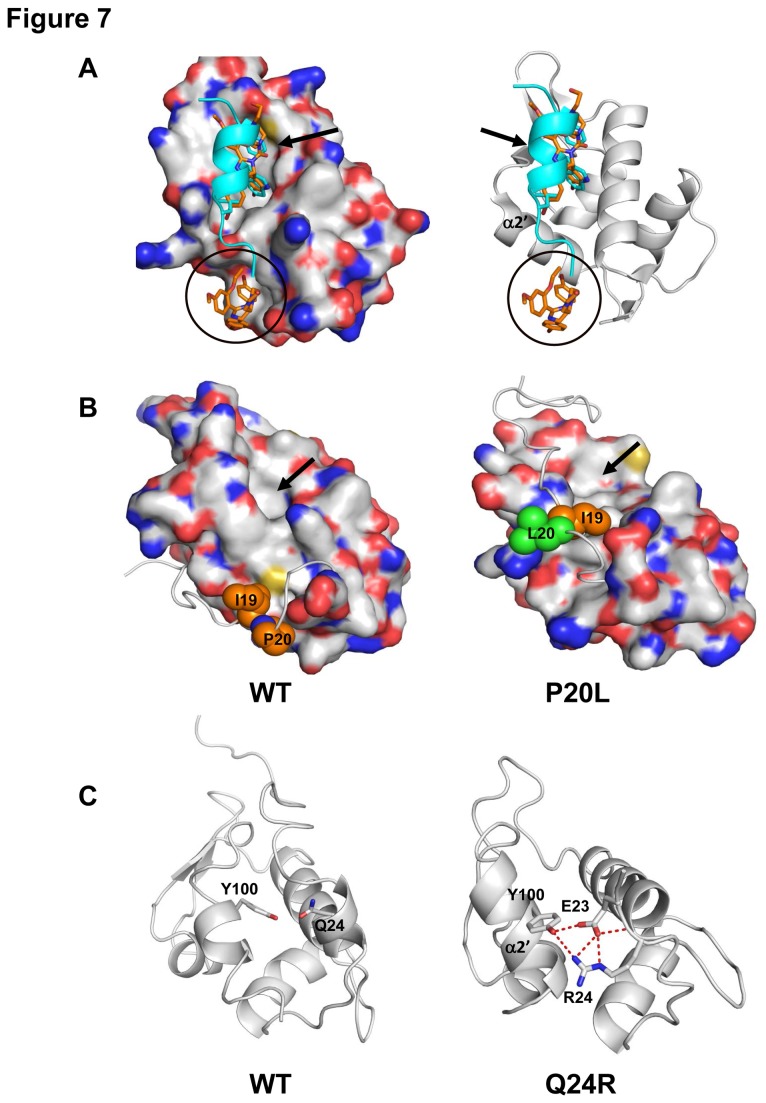
Molecular simulations show negative impact of the P20L and Q24R mutations on the docking of Nutlin to the HDM2 N-terminal domain.A, Space-filling (left) and ribbon (right) depictions of Nutlin (orange) binding the main (arrowed) and secondary (circled) binding sites of HDM2. The p53-peptide (cyan) binding to the main site is overlaid. B, Space-filling model of the HDM2 N-terminal domain showing migration of the lid region when P20 (left, orange sphere,) is mutated to leucine (right, green sphere). Arrow depicts main Nutlin binding site. C, Mutation of Q24 (left) to arginine (right) results in extensive hydrogen bond network with E23 and Y100 and likely occlusion of the secondary Nutlin binding site.